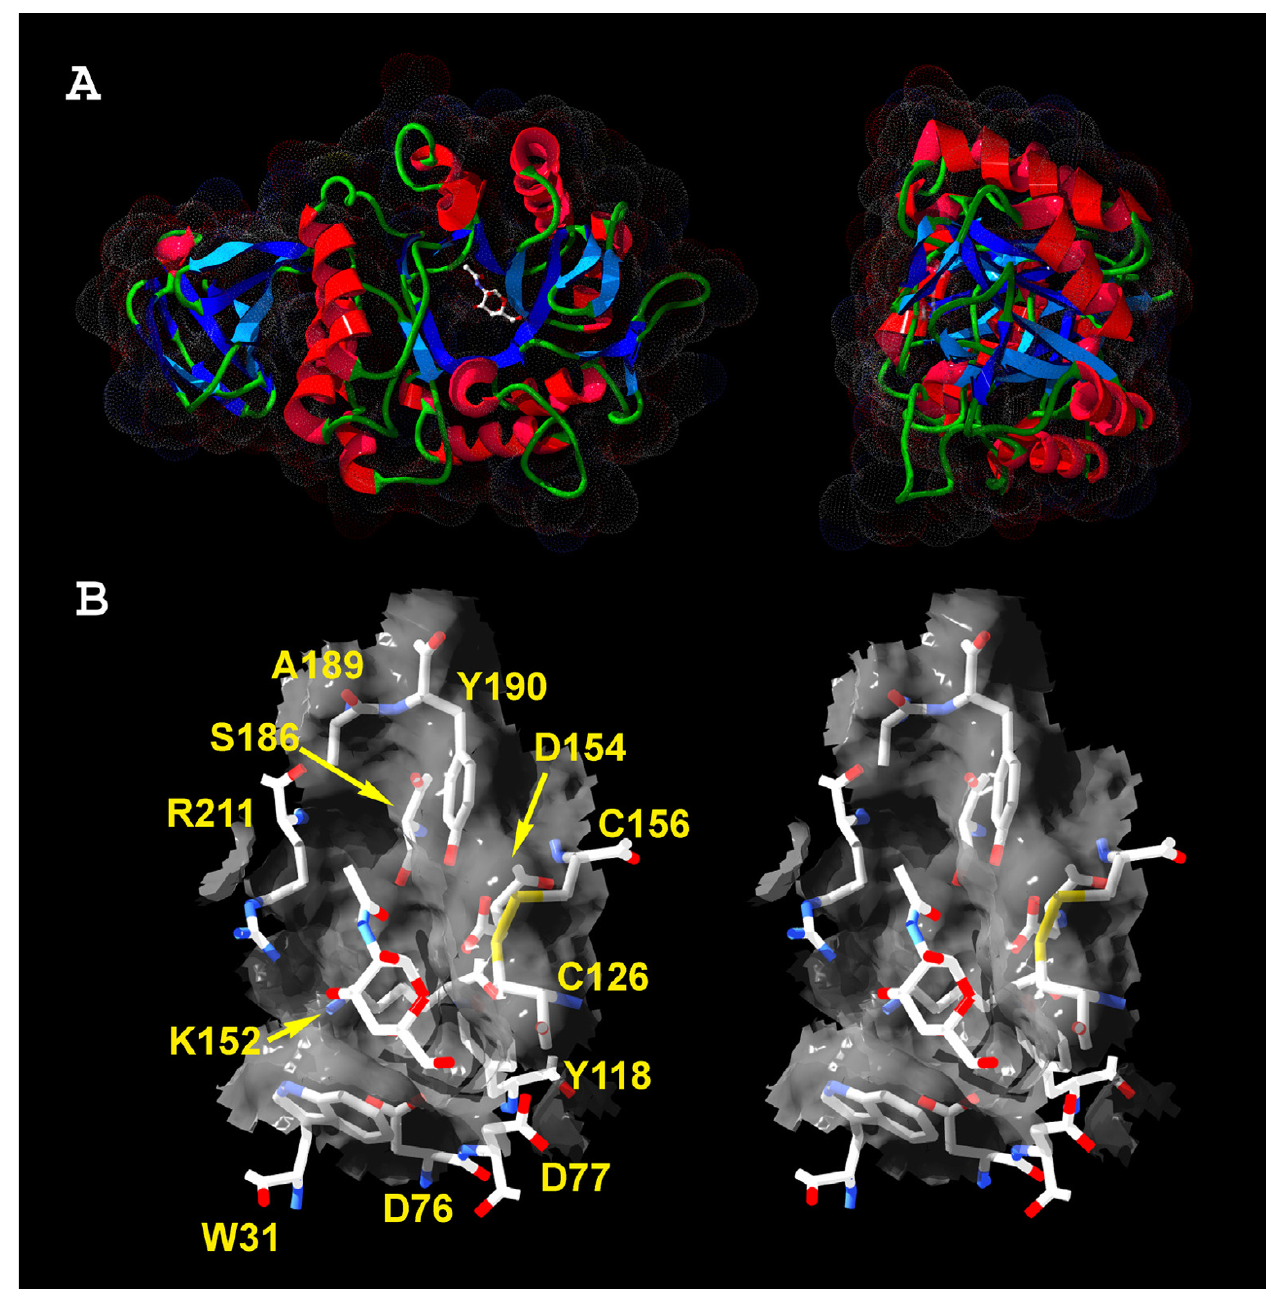
Figure 4 GANA-1 protein model. A) Ribbon representation of GANA-1 monomer model. A two-domain structure is apparent in the left picture. The N-acetyl-D-galactosamine (inhibitor) is placed into the active site. Dots represent VdW radii of surface atoms. B) Stereo picture of the active site pocket with N-acetyl-D-galactosamine (inhibitor) and amino acid labels. The viewing angles for stereo representation of the protein structure are ±2 degrees from the central